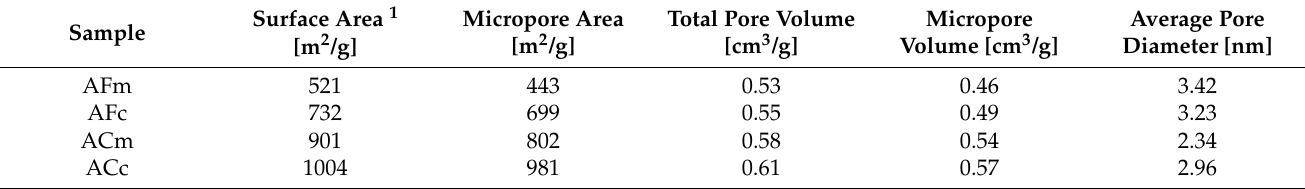
Table 2. Textural parameters of the biocarbons obtained.